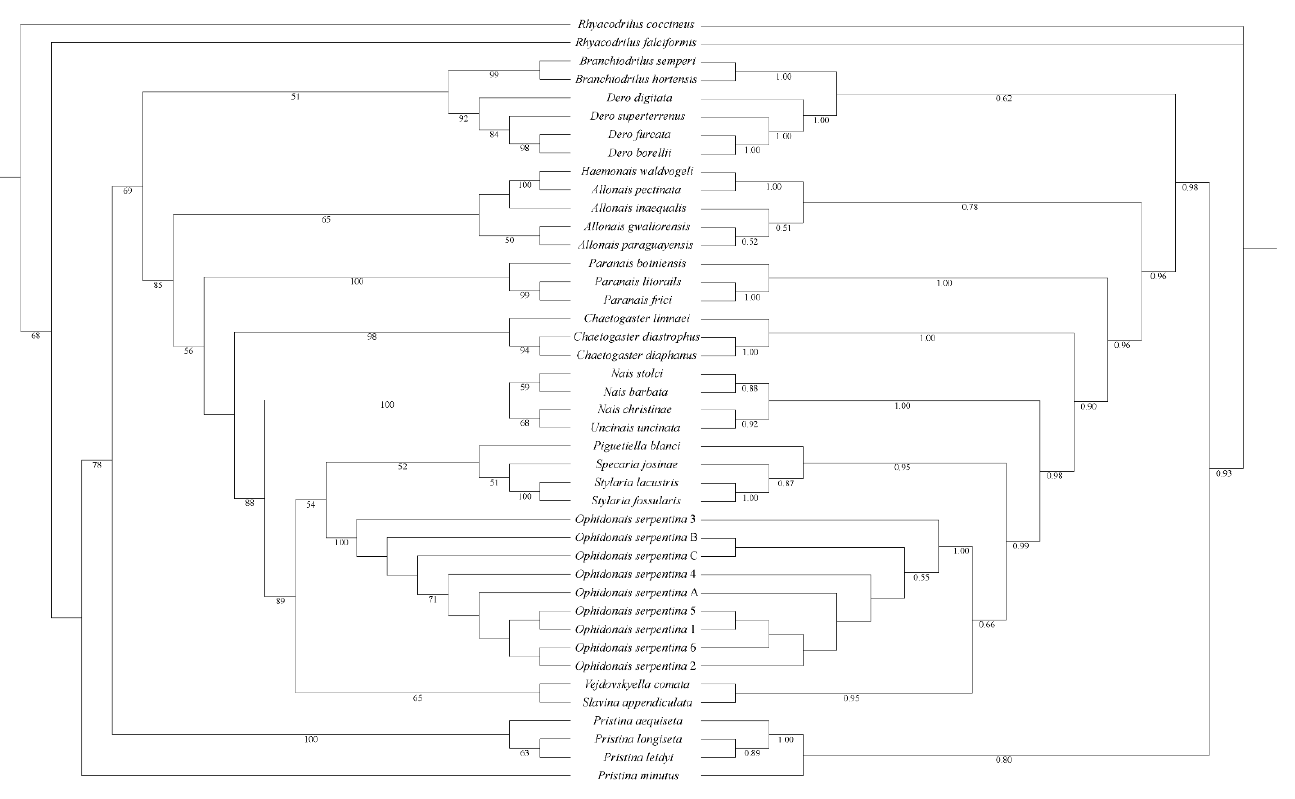
Figure 4. Phylogenetic trees obtained from the maximum likelihood ( left ) and Bayesian ( right ) analysis of the combined dataset.